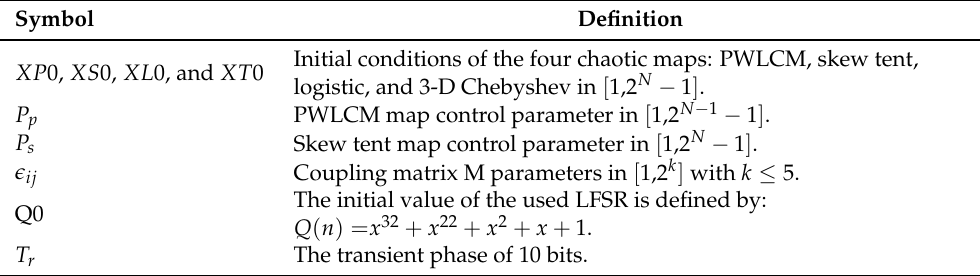
Figure 3. The architecture of the proposed pseudorandom number generator of chaotic sequences. Table 1. Initial conditions and parameters that form the secret